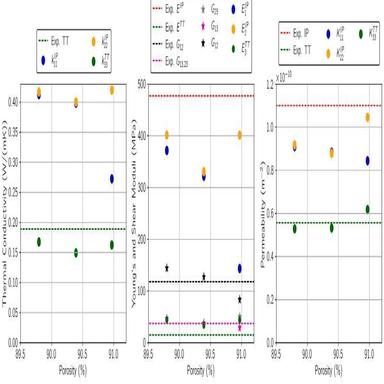
Thermal conductivity (left), elasticity (middle), and permeability (right) for the three FiberFormTM μCT samples.